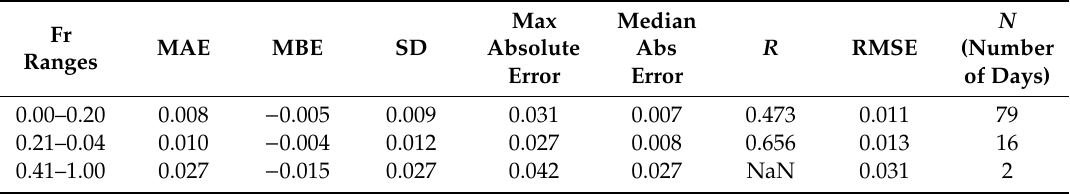
Table 6. Summary of SSM comparisons per Fractional Vegetation Cover (Fr) for all the experimental sites and all parameters for the year 2018. All statistical parameters apart from correlation coe ffi cient ( R ) and sample size ( N ) are expressed in cm 3 cm − 3